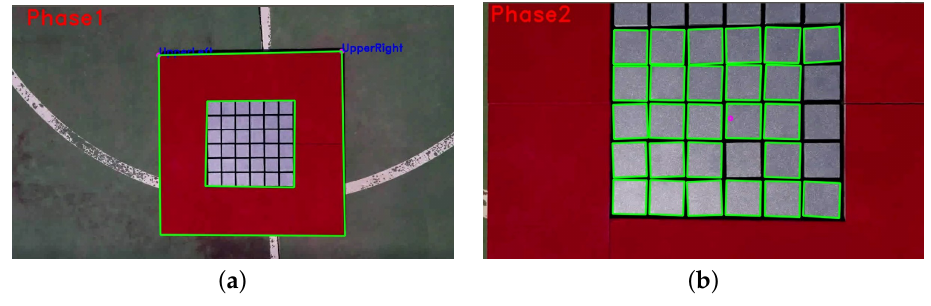
Figure 9. Two-phase detection algorithm. ( a ) Phase 1; ( b ) Phase